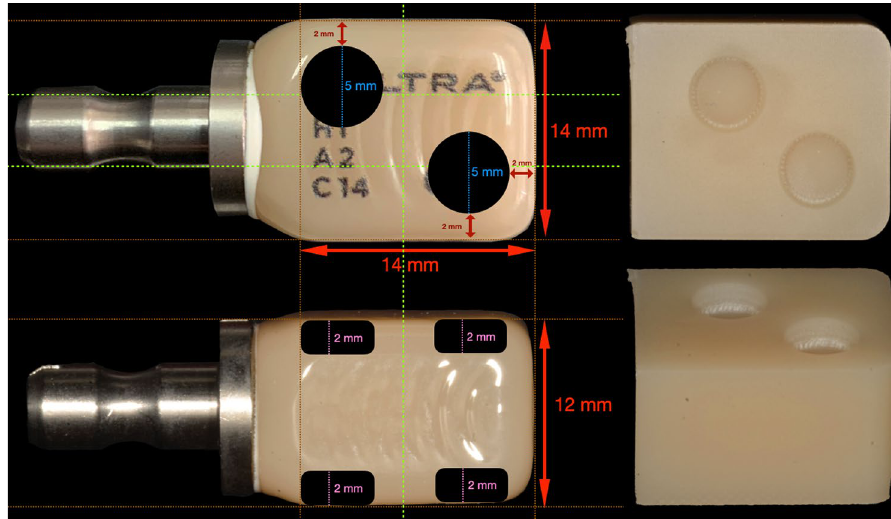
Figure 1. Design for creating 4 wells on the top and bottom surfaces of glass ceramic blocks.